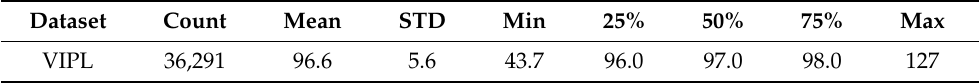
Figure 5. Histogram ( a ) and box plot ( b ) of SpO2 engineered datasets from the extracted green- channel AC-component data. Table 3. Statistical Summary of the SpO2 Engineered Datasets Based on the Extracted Green- Channel